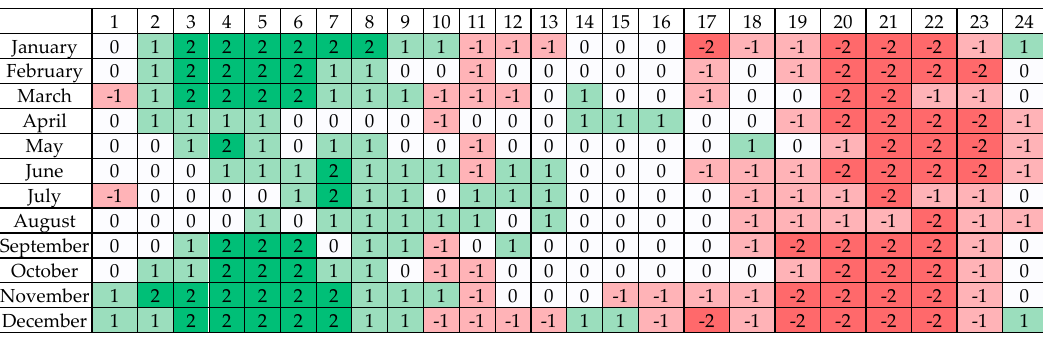
Figure 18. Strategy to optimise the load shifting: non-working days. ( − 2, Green) Strong Load reduction; ( − 1, Light Green) Weak Load reduction; (0, White) No Load variation; (1, Light Red) Weak Load increase; (2, Red) Strong Load increase.